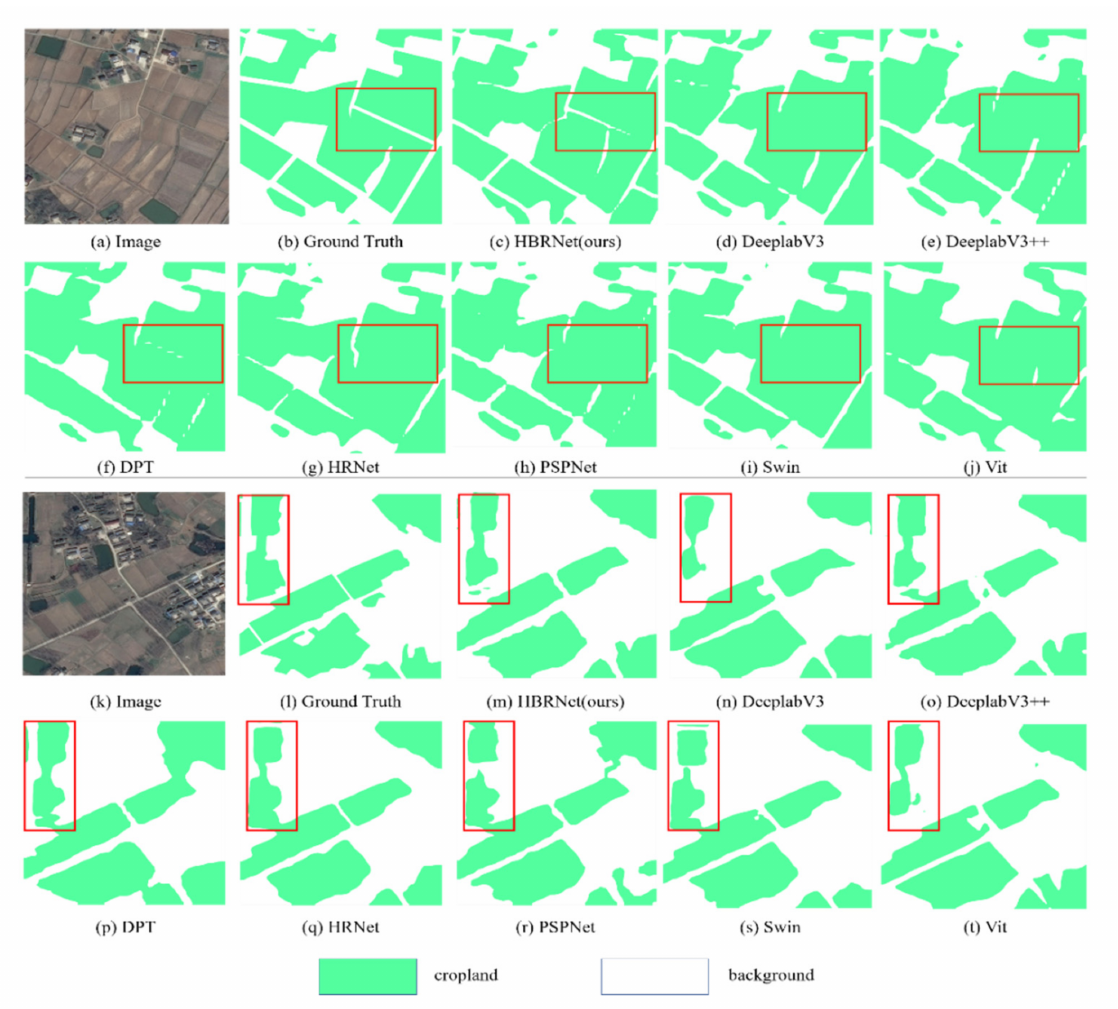
Figure 12. Visualization of results on the Agriculture dataset. The green represents the distribution of cropland and the white is the background. We can focus on comparisons of the details in the red boxes when observing the figure of the experimental